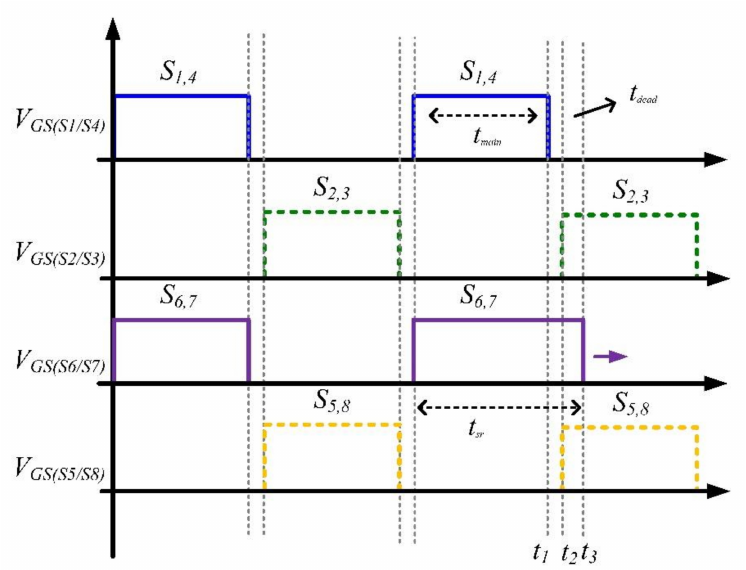
Figure 14. Upper limits of the SR switches.